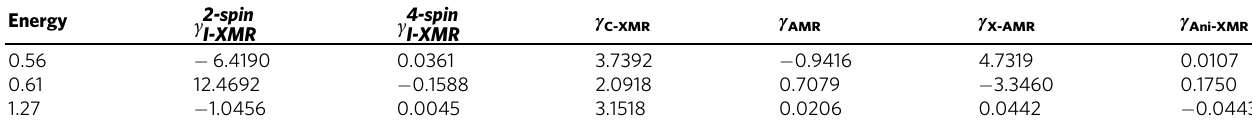
Table 1 Energy-dependent weights of the various unveiled spin-mixing magnetoresistances. Energy